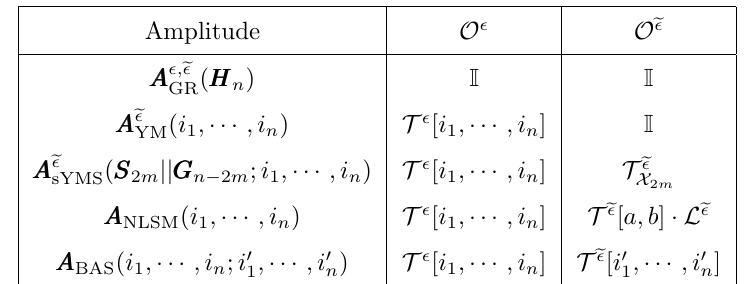
Table 2 . Unifying relations for di(cid:11)erential